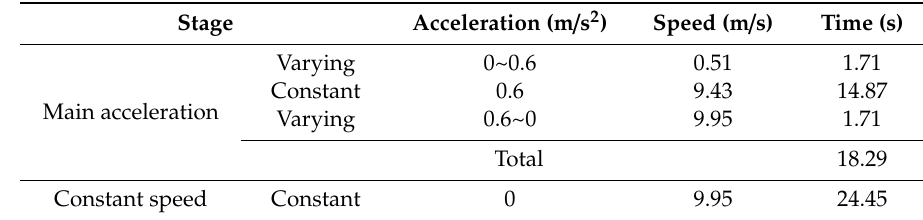
Table 2. Operating parameters (Acceleration and Constant Speed